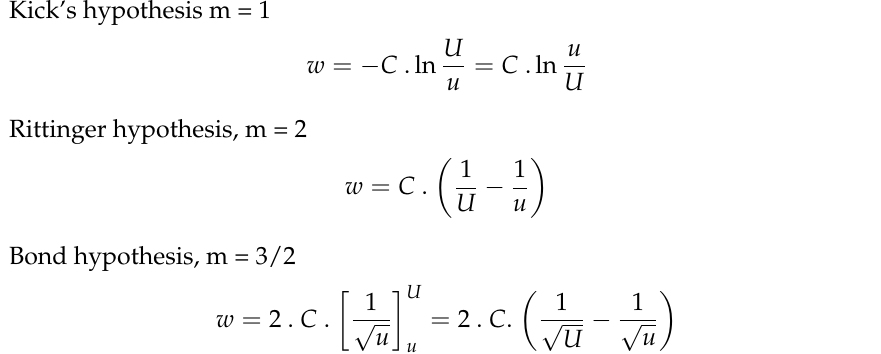
Figure 1. Specific work of uncoupling “w” as a function of particle size “u”. Charles’ decoupling equation includes all known equations and theories: where w is the specific uncoupling work; u is the particle size; C is a constant of pro- portionality that characterizes the strength of the material; and m is an exponent depend- ent on the type of energy supplied, e.g., pressure, shear.